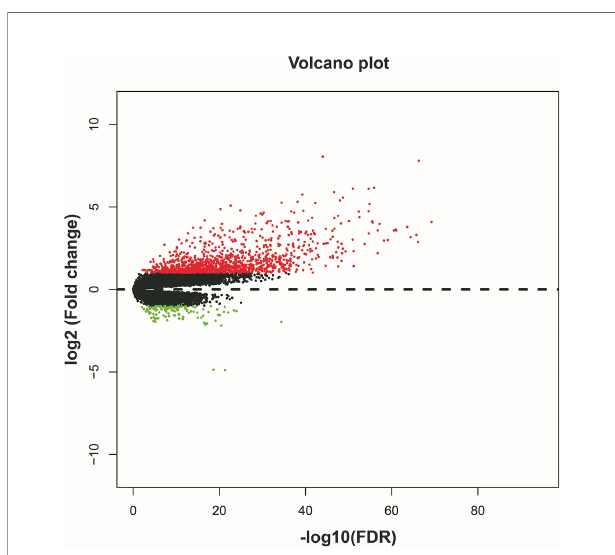
FIGURE 8 | Volcano plot of DEGs between high- and low-risk score phenotypes.